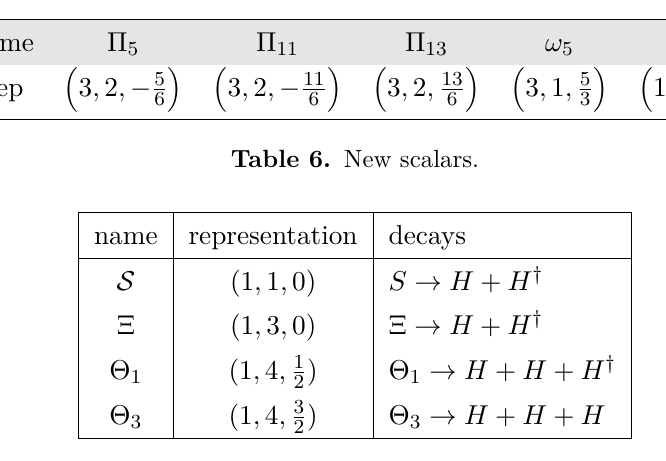
Table 7. Decay channels for scalar